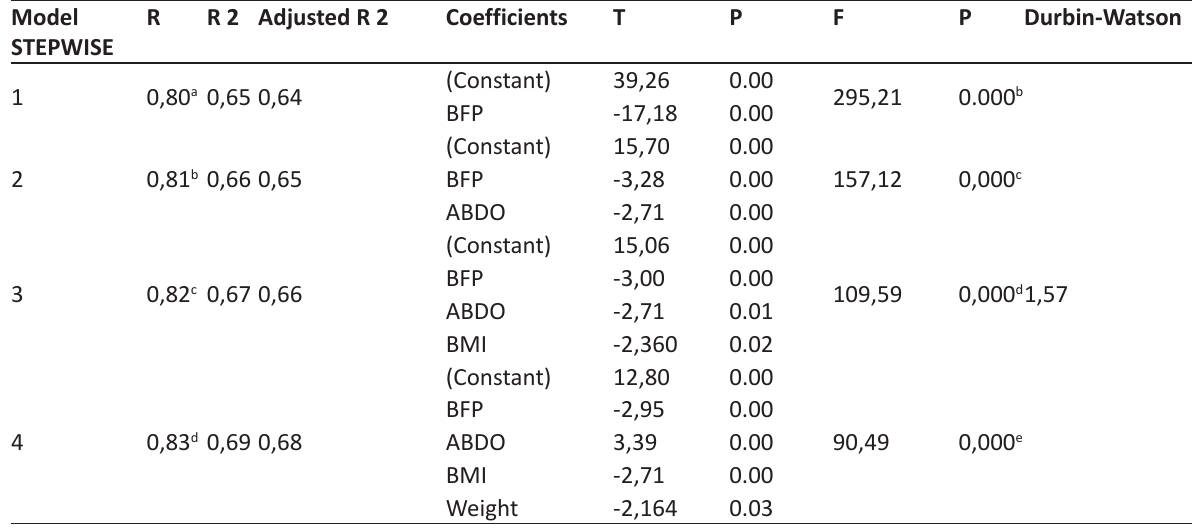
Table 4. Presents the Results of regression analyses relating dynamic balance (DB)and the anthropometrics variables used in the current